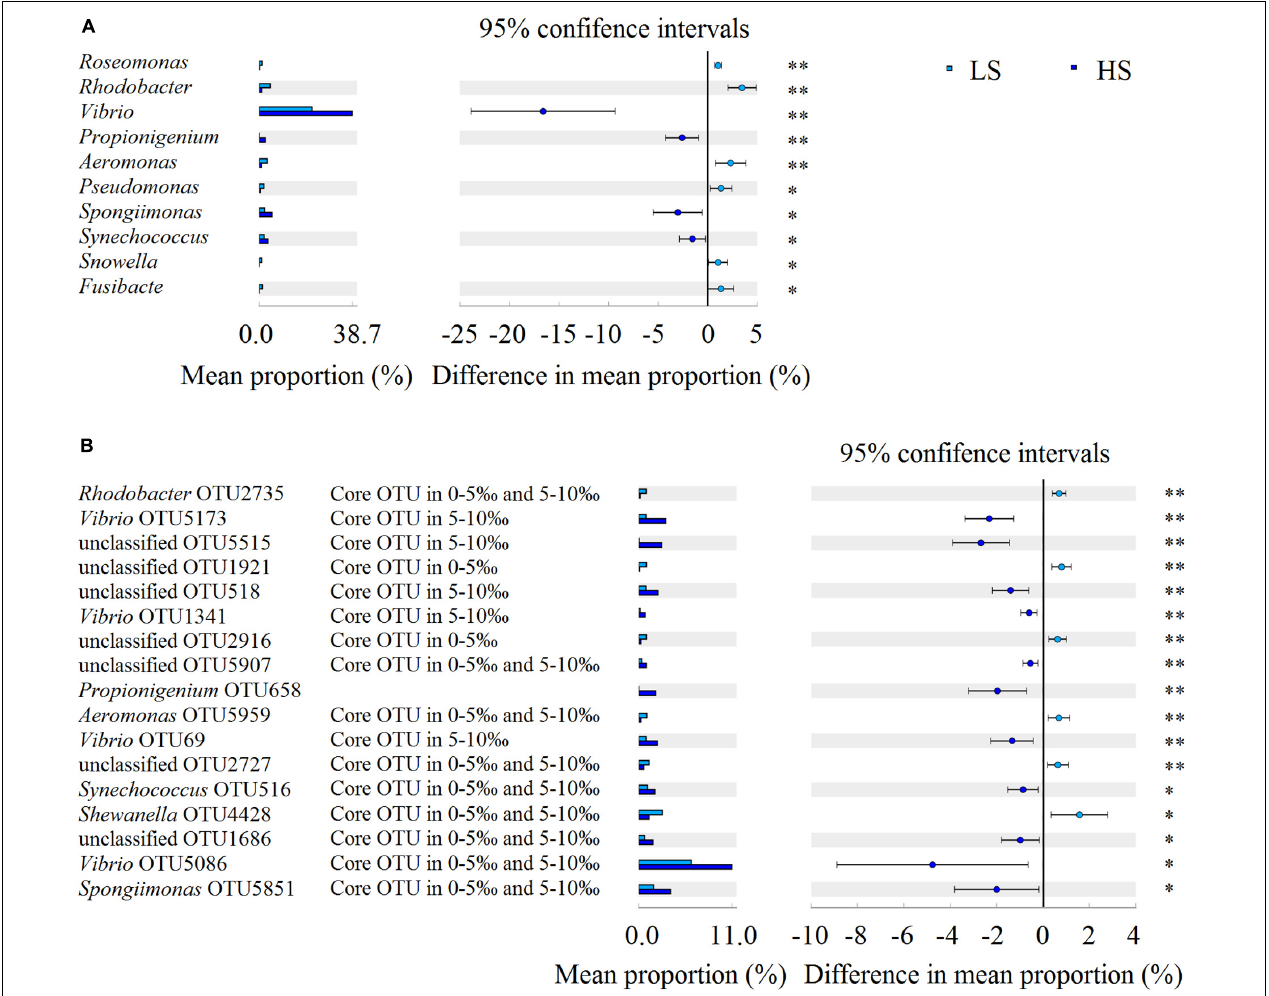
FIGURE 4 | Bacterial taxonomic comparison of shrimp intestine in the LS and HS groups. Welch’s t -test results showed that the relative abundances of the 10 genera (A) and 17 OTUs (B) had significant differences between the LS and HS groups ( ∗ P < 0.05, ∗∗ P <